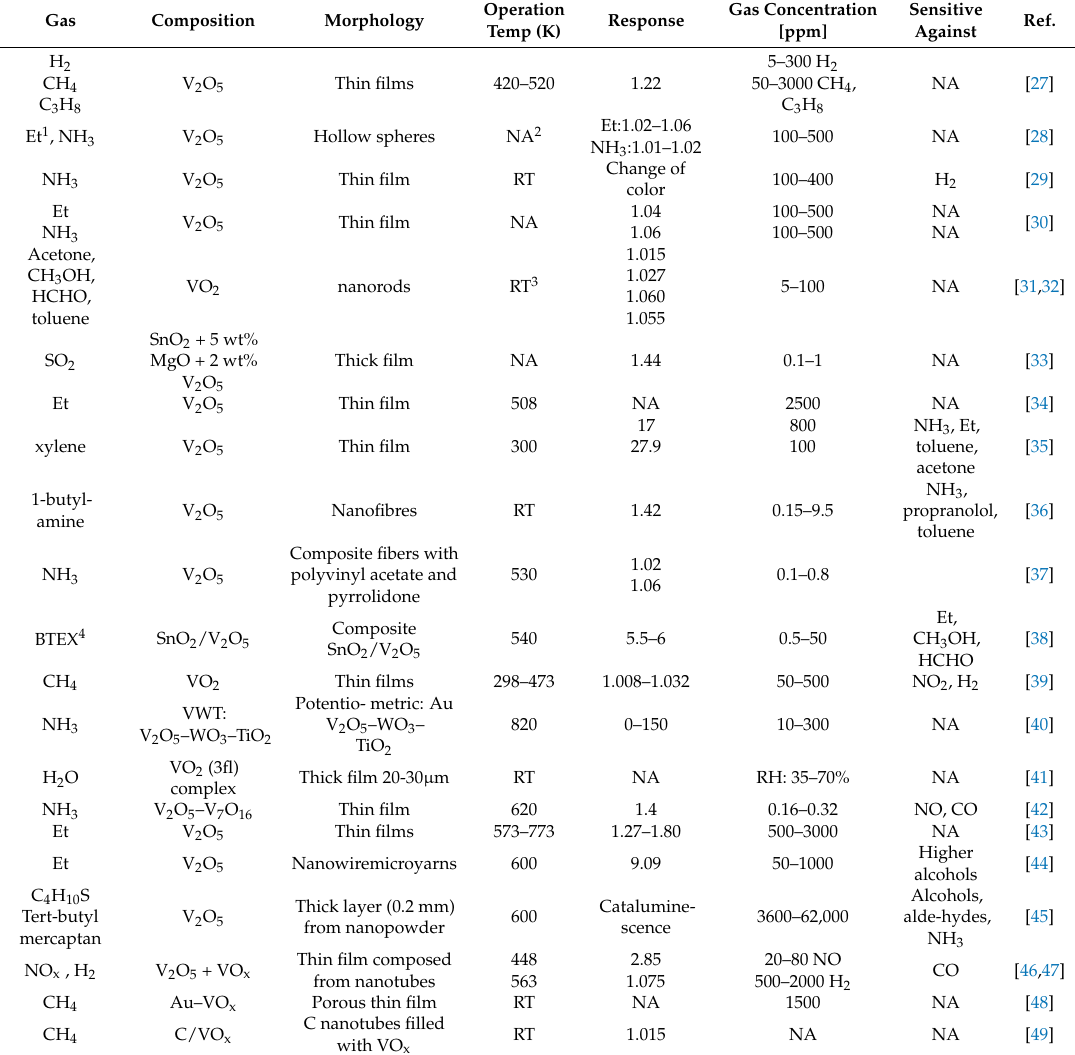
Table 1. Vanadium oxide-based gas sensors, literature survey (published between 2010–2017).